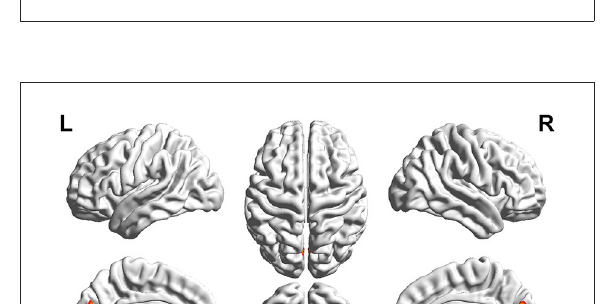
FIGURE5 T -value map of increased gray matter volume in the patients with right acoustic neuroma compared with healthy controls. Compared with healthy controls, the brain regions with increased gray matter volume in the patients with right acoustic neuroma were: the right fusiform and parahippocampal gyrus. The statistical threshold was voxel-wise p < 0.001 with cluster-wise FWE corrected p < 0.05 (513 voxels).